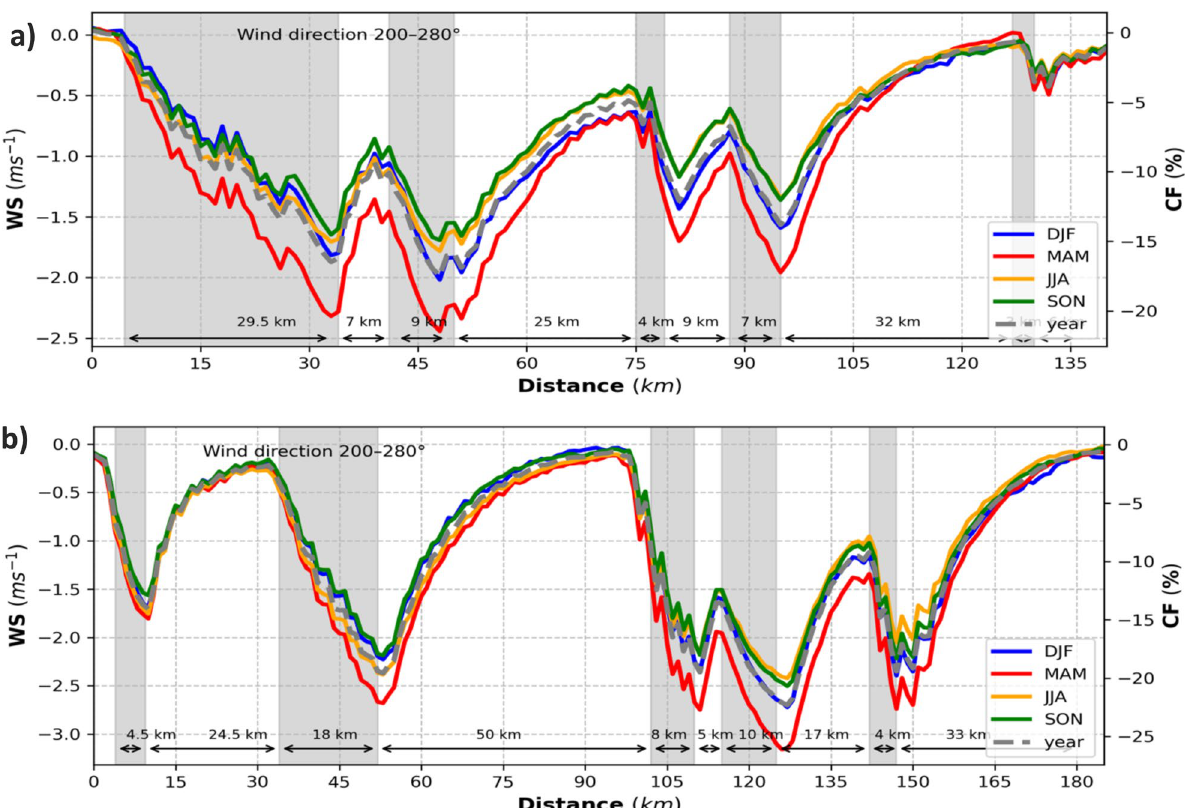
Figure 8. ( a ) Transects of the seasonal (colored, see legend) and yearly mean (dashed gray) wind speed deficits (left axis; CCLM_WF – CCLM) and capacity factor losses (right axis; CCLM_WF – CCLM) for the prevailing wind directions of 200°–280° in the period 2008–2017 at hub height (90 m) taken at transect I (German Bight, Fig. 5) latitude 54.2 latitude 54.2°N–55.6°N and longitude 5.45°E–8.0°E. Gray sectors indicate the wind farm positions. Arrows and attached numbers give the distances between the edges of the wind farms. ( b ) As of ( a ) but for transect III (Dogger Bank, Fig. 5) latitude 54.4°N–55.8°N and longitude